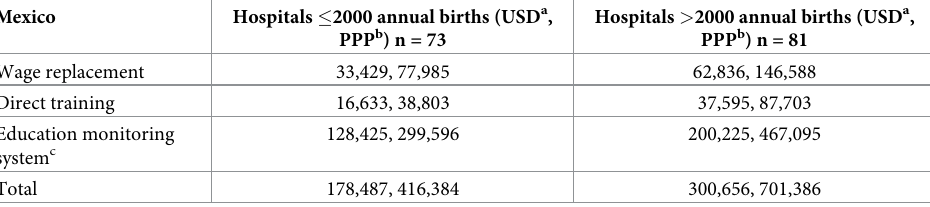
Table 7. First-year implementation cost estimates (in USD) for BFHI training in Mexico by hospital size.